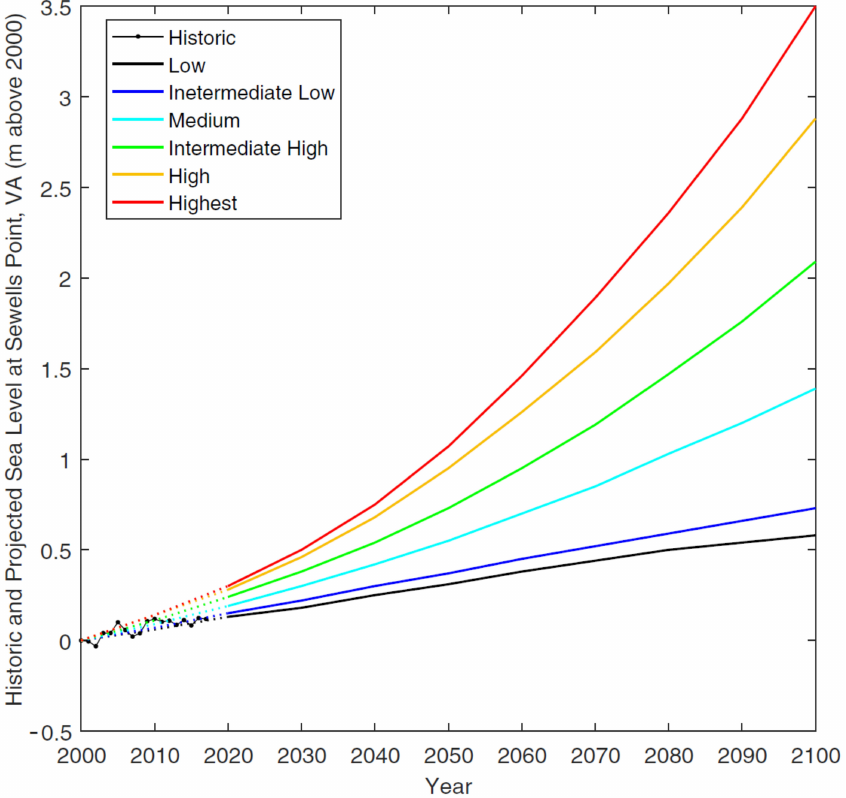
Figure 4. Historical and projected relative sea level at the Sewells Point tide gauge in Norfolk, VA